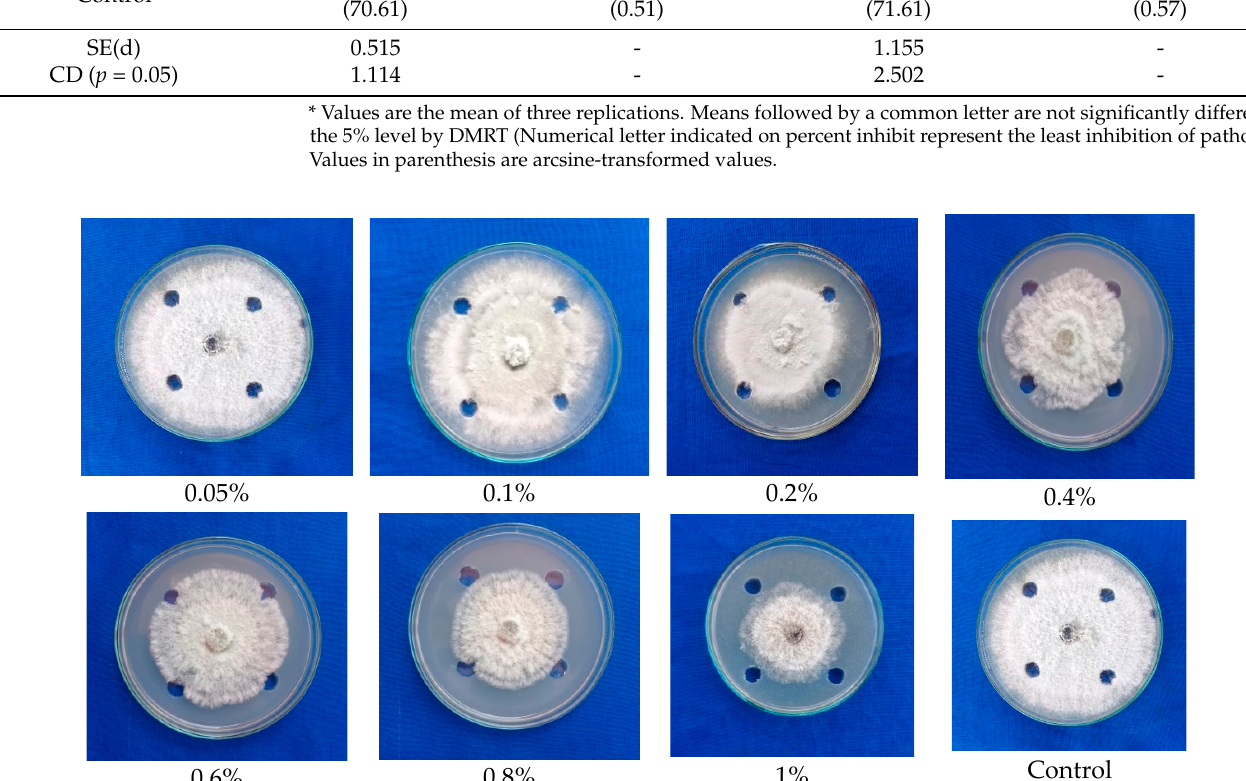
Figure 3. Testing the ethyl acetate extracted antimicrobial compounds from the fruiting body (Stipe) of G. lucidum against mycelial growth of C. gloeosporioides.